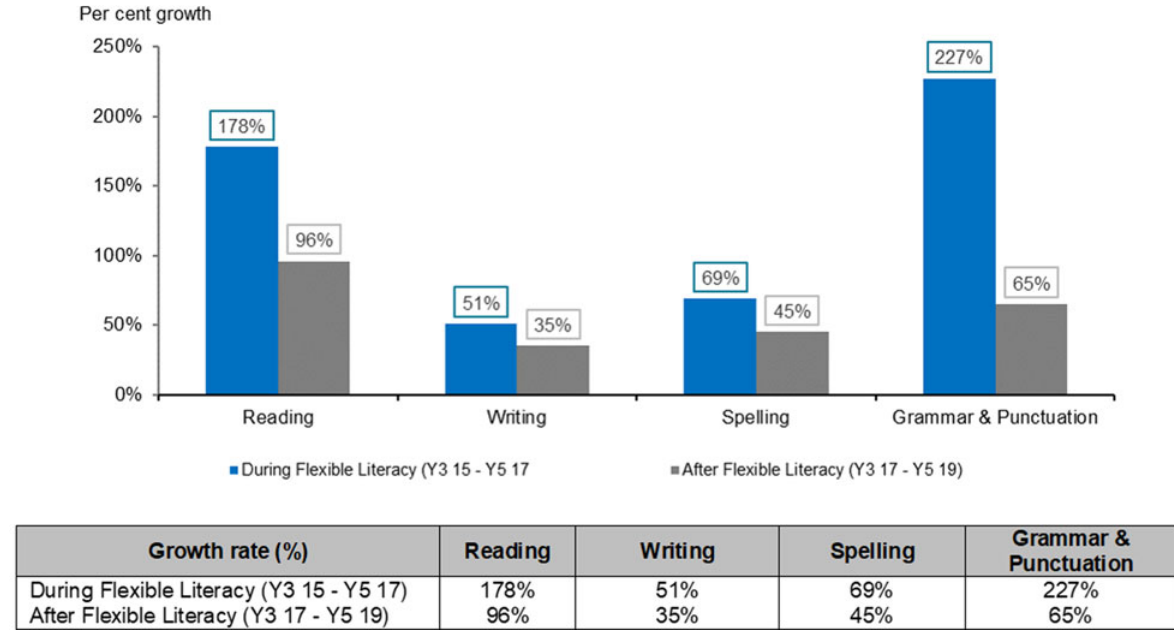
Fig. 3. NAPLAN literacy growth made by test area by 14 discontinued schools while participating in the Flexible Literacy (Year 3 2015 – Year 5 2017) compared to after leaving (Year 3 2017 – Year 5